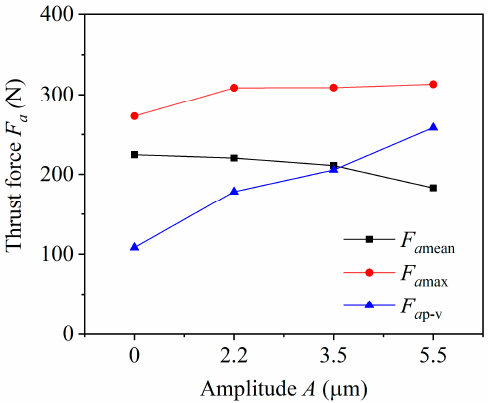
Figure 5. Thrust forces of UVD at various amplitudes. ( n = 1200 r/min, v f = 36 mm/min, f = 20 KHz).